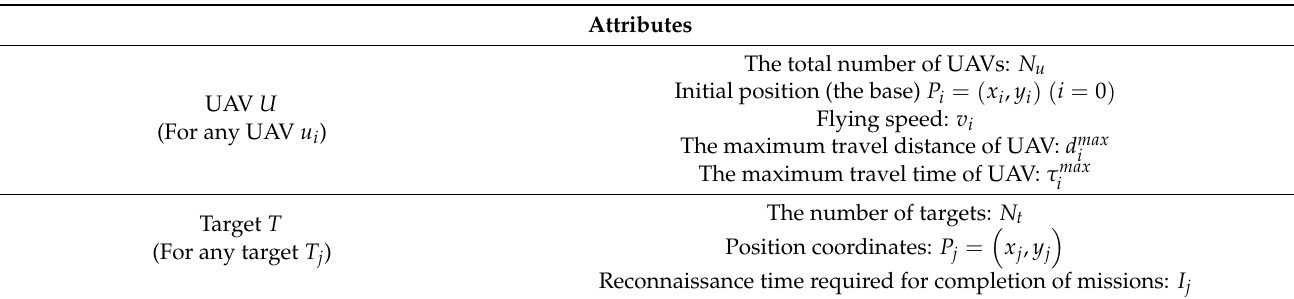
Table 1. Object attributes and symbol